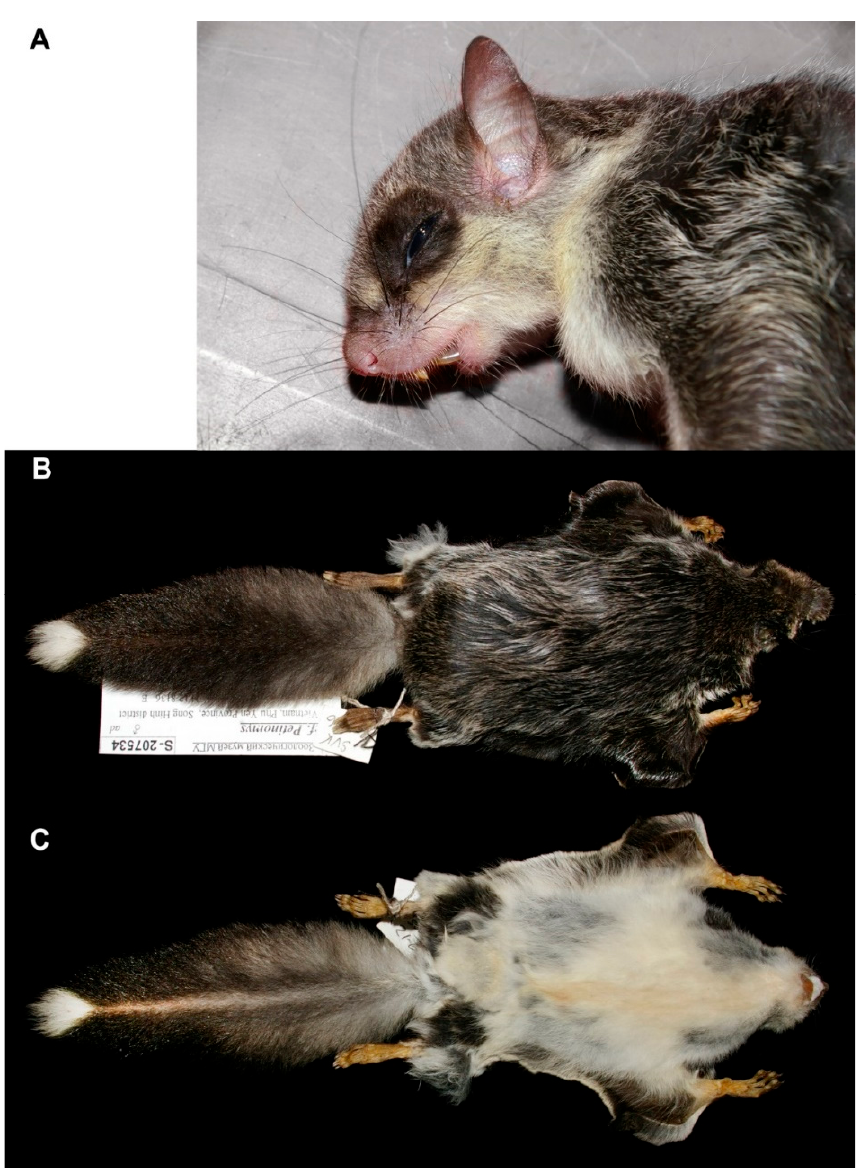
Figure 1. External appearance of the specimen ZMMU S-207534 from Phu Yen Province: head, showing characteristic fur coloration and ear shape ( A ) and the study skin from above ( B ) and below ( C ).